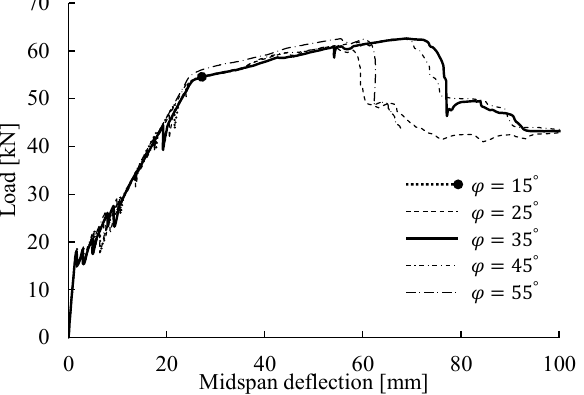
Figure 10. Load–midspan deflection relations for different dilation angles ranging from 15° to 55°.